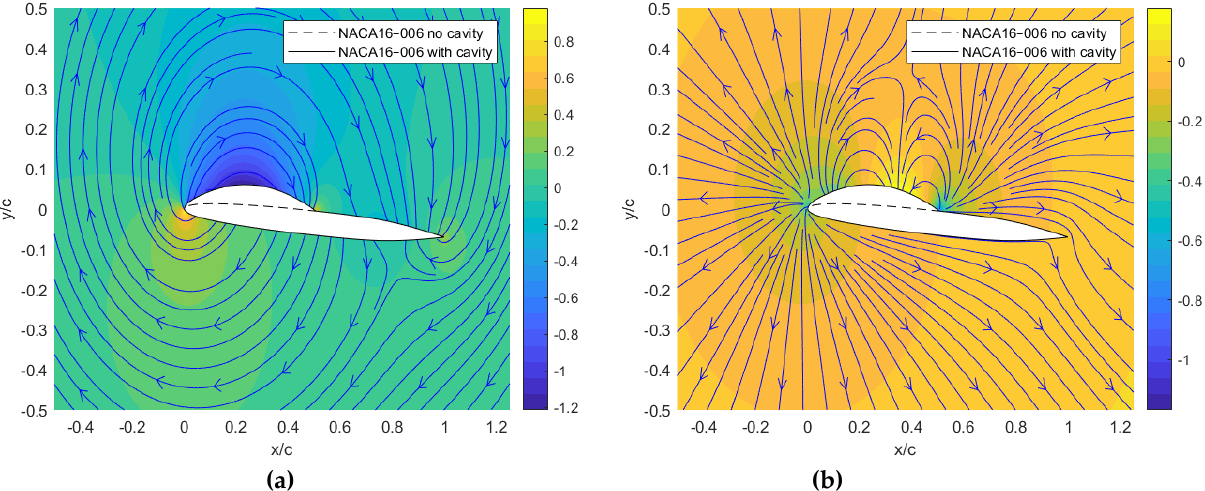
Figure 4. Numerical results for the NACA16 – 006 hydrofoil at α = 4 deg. ( a ) Pressure coefficient and disturbance velocity field streamlines. ( b ) Adjoint potential ψ and velocity streamlines.